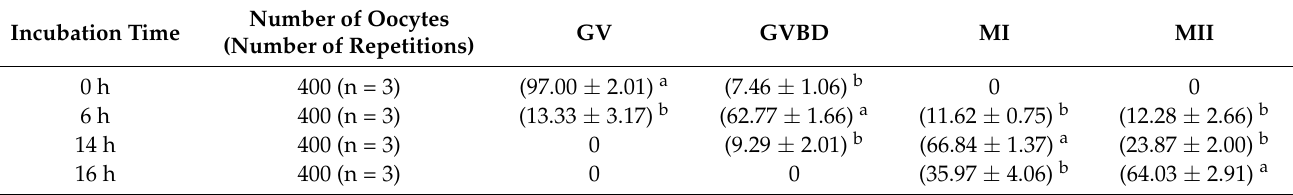
Table 5. Number of cells at different stages of IVM oocyte in experimental groups.